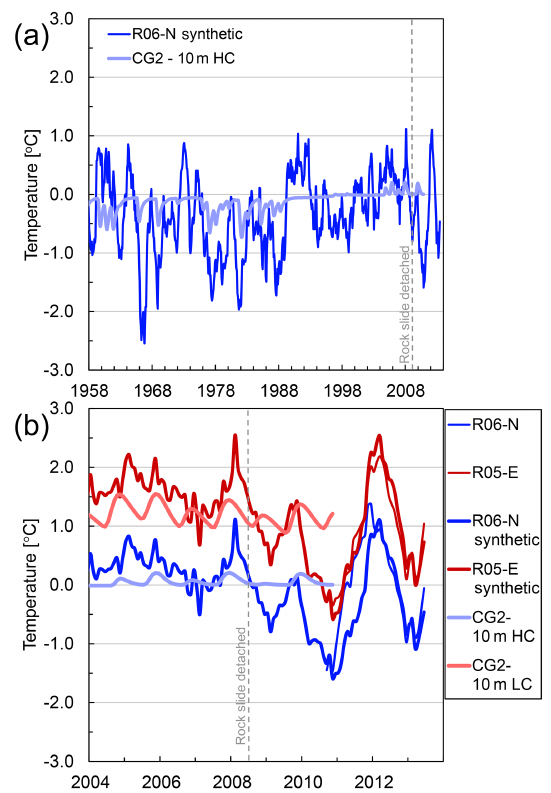
Figure 8. (a) Synthetic temperature series since 1958 of the cold- est rock wall site (R06) based on the regression presented in Fig. 6. Also shown is the transient permafrost model CryoGrid2 (CG2) run that calculates ground temperatures at 10m depth according to con- ductive heat transfer in the soil and in the snowpack (Westermann et al., 2013). The CG2 model results are representative for areas at ap- proximately 665ma.s.l. with slope gradients allowing for snow ac- cumulation. The grey dotted line shows when the Signaldalen rock avalanche detached; (b) The recent 10-year period for the synthetic series overlaid on the respective in situ RST data for the lowest (R06, blue lines) and highest (R05, red lines) rock wall tempera- tures. Also shown are the CG2 model data runs at 10m depth for high (HC) and low (LC) thermal conductivity values of the